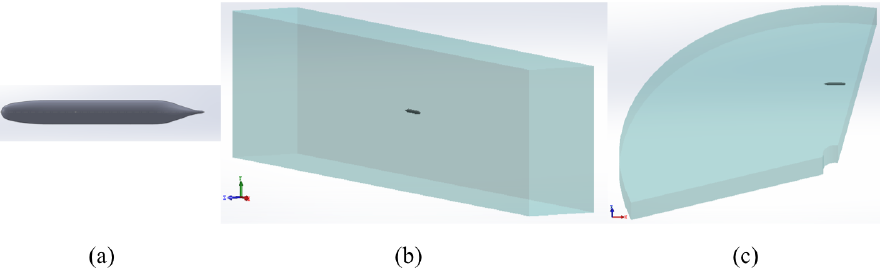
Figure 16. ( a ) Standard SUBOFF model; ( b ) computational fluid domain for towing test simula- tion of SUBOFF model; and ( c ) computational fluid domain for rotating arm test simulation of SUBOFF